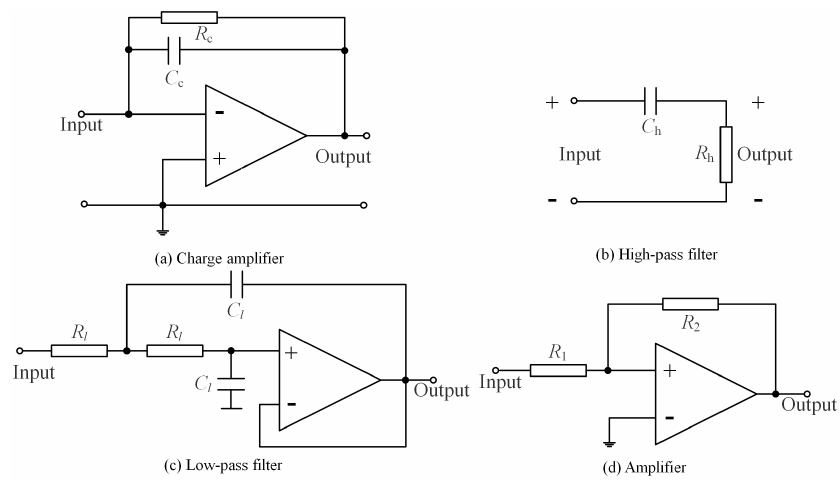
Figure 4. Analog circuit diagram: ( a ) charger amplifier, ( b ) high-pass filter, ( c ) low-pass filter, ( d )